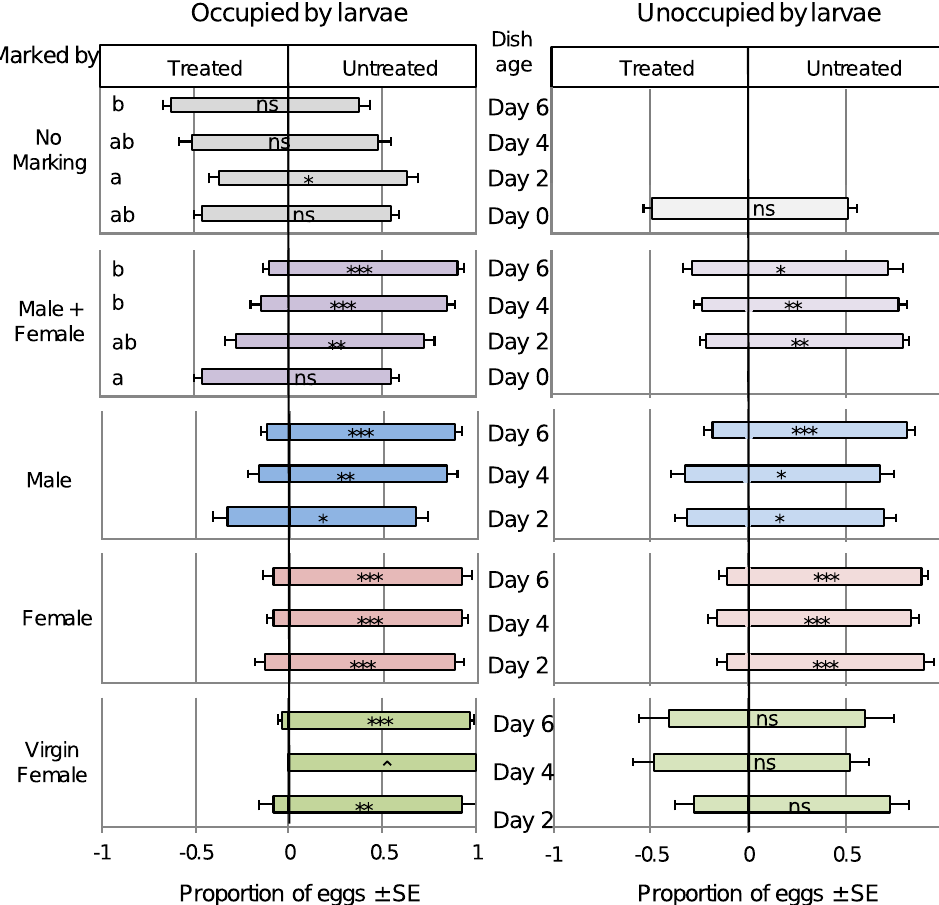
Figure 3. Larval density and host marking type affect D. suzukii oviposition preference. Data are presented as proportion of eggs laid in each dish ± SE. ‘Treated’ = marked and/or occupied substrate, ’Untreated’ = unmarked, unoccupied substrate. All dishes, except untreated dishes, were exposed to 10 D. suzukii adults for 4 h, followed by adding or removing eggs for the ‘occupied’ treatment. Dishes were either assayed again immediately, or held for a number of days prior to assay. Bars that share the same letter within each panel are not significantly different (Kruskal Wallis, Dunn Test, p > 0.05). Asterisks indicate significance values as follows: * p < 0.05; ** p < 0.01; *** p < 0.001 (Paired t-test). ⌃ No eggs were counted on the marked